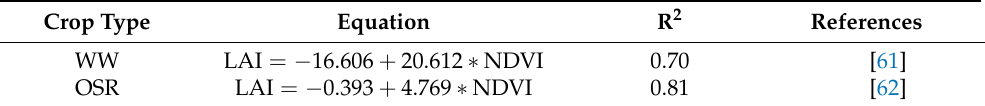
Table 3. A summary of equations used to calculate LAI from NDVI satellite products for WW and OSR. These equations are derived from the growth stage of a crop until the flowering stage. The LAI product is used as an input to the WOFOST